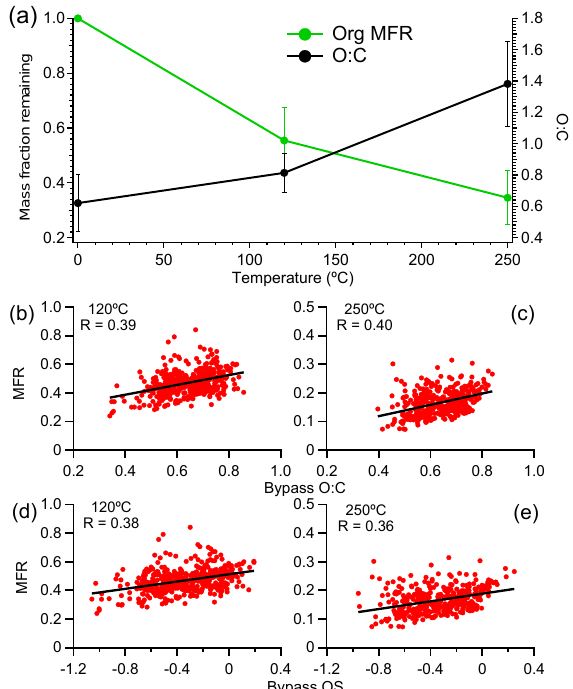
Figure 12. (a) Organic mass fraction remaining (MFR) and O:C as a function of TD temperature; (b–e) organic MFR at 120 and 250 ◦ C as a function of bypass line organic O:C and oxidation state.